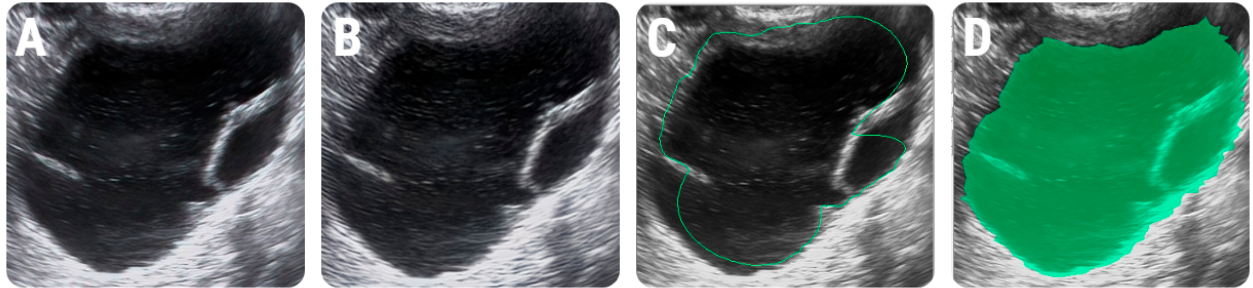
Figure 1. Image pre-processing workflow and the positioning of the region of interest (ROI). ( A ) The ultrasound image of a 34-year-old patient with histologically-proved mucinous cystadenoma that underwent speckle-noise reduction ( B ); the initial ROI that was automatically delineated by the software (green line) ( C ) and the final ROI after manual adjustments (green) ( D